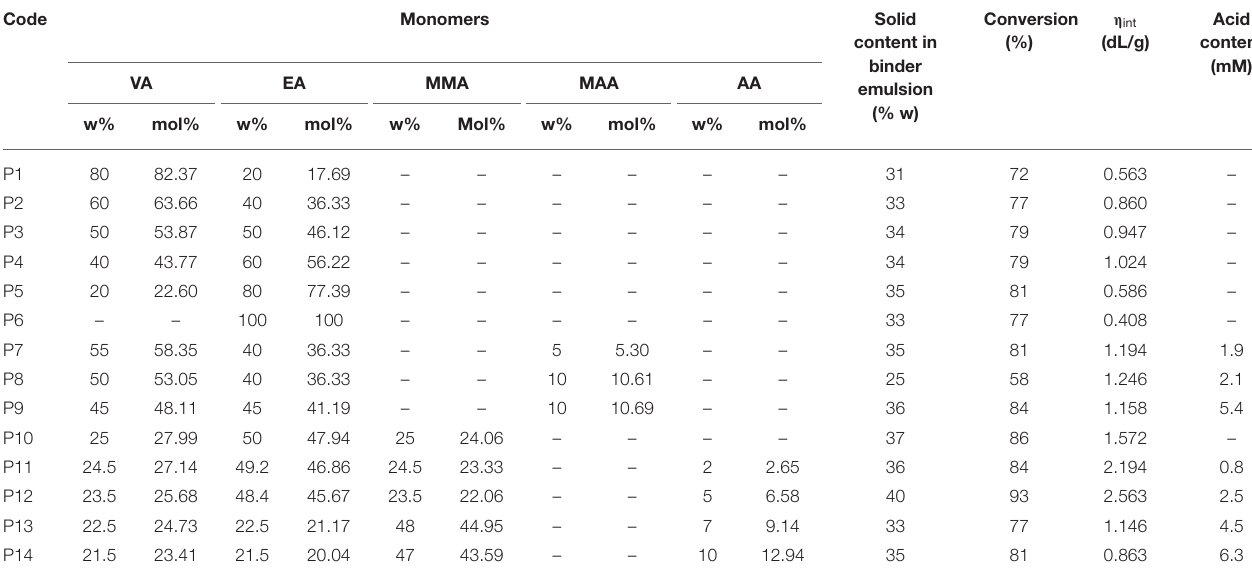
TABLE 1 | Monomer composition, solid content, and intrinsic viscosity of the